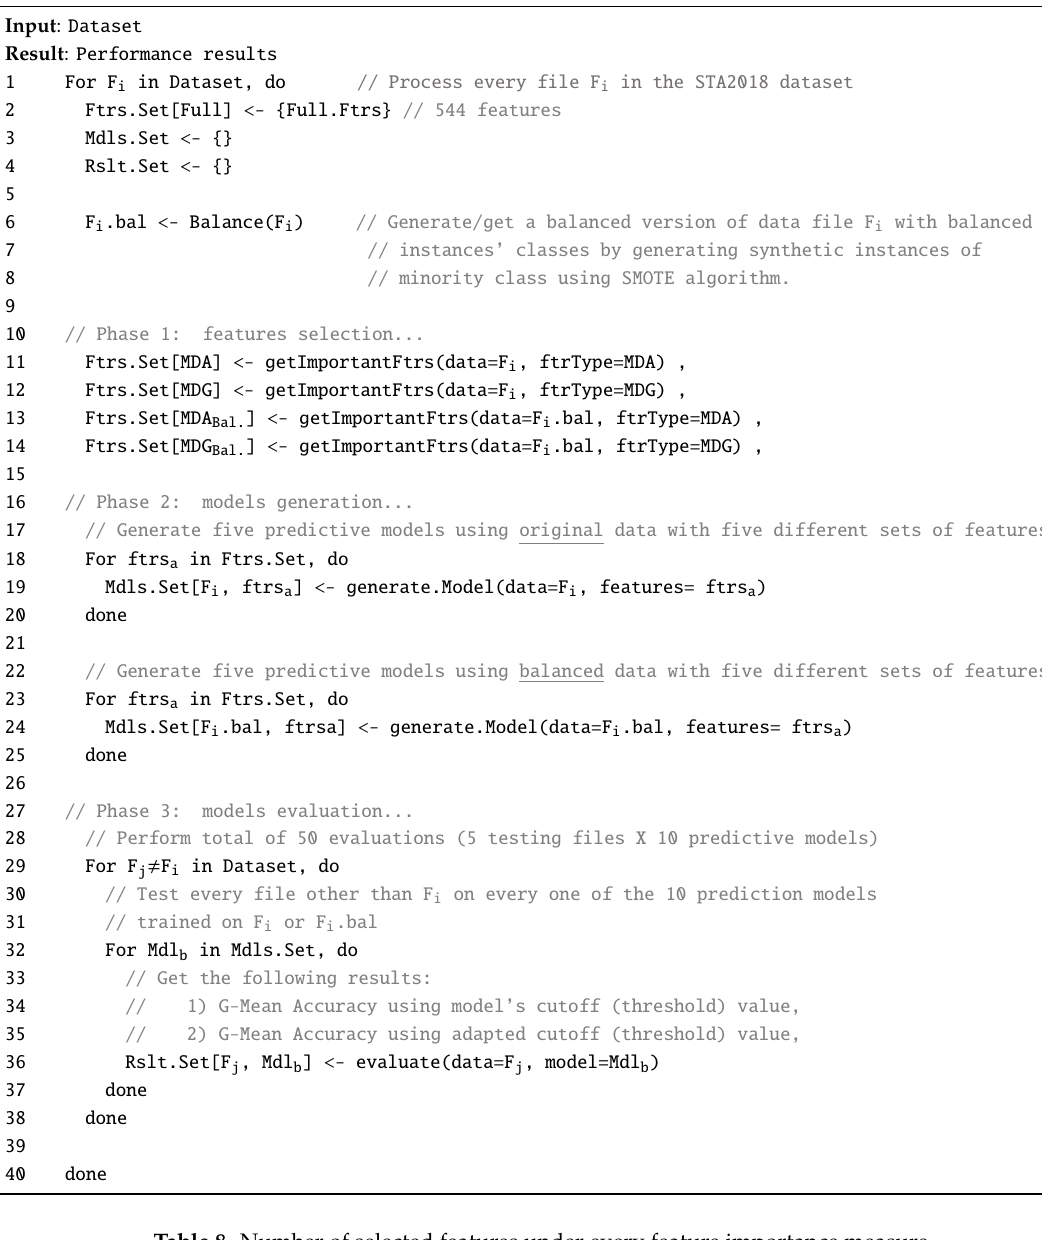
Table 8. Number of selected features under every feature importance